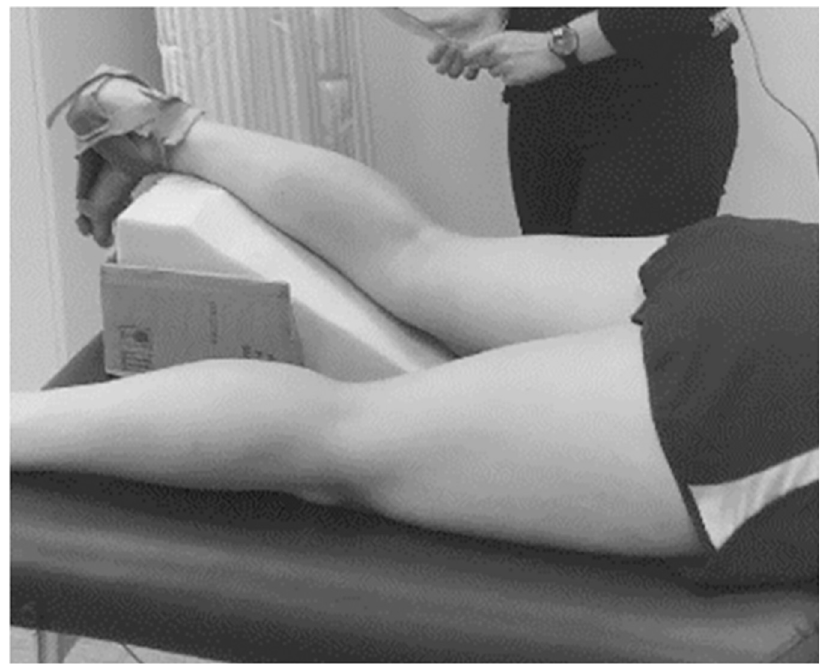
Fig 1. Position of lower limb during